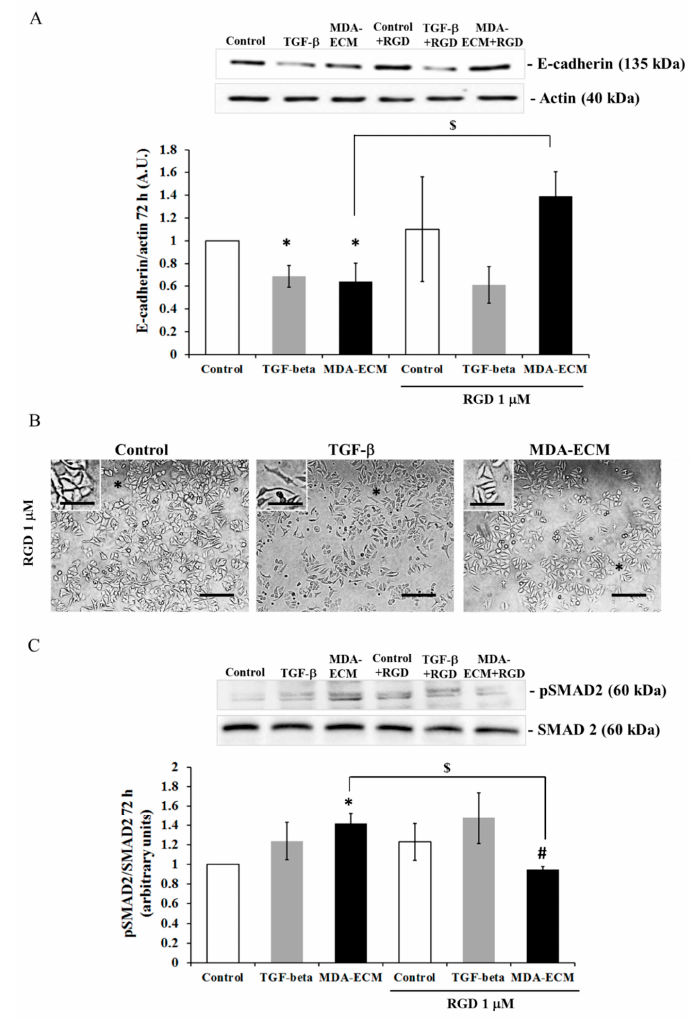
Figure 7. Integrin signaling modulated the e ff ects of MDA-ECM on E-cadherin-mediated adhesion of MCF-7 cells. MCF-ECM and MDA-ECM were obtained, as described in the Methods section. MCF-7 cells were cultured on their own ECM with or without TGF- β 1 or on MDA-ECM and treated with Arg-Gly-Asp (RGD) for 72 h (1 µM). Cell lysates were immunoblotted with ( A ) anti-E-cadherin and ( C ) anti- p -SMAD2 antibodies. ( B ) Representative images of MCF-7 cell cultures of each experimental group, treated or not with RGD (1 µ M), at 40 × magnification. A black asterisk indicates lost or remaining intercellular connections. Scale bar: 20 µ m. The results are shown as the mean fold increase relative to controls: MCF-ECM (* p < 0.05), MCF-ECM + RGD (# p < 0.05), and MDA-ECM ($ p < 0.05), calculated from 3 individual